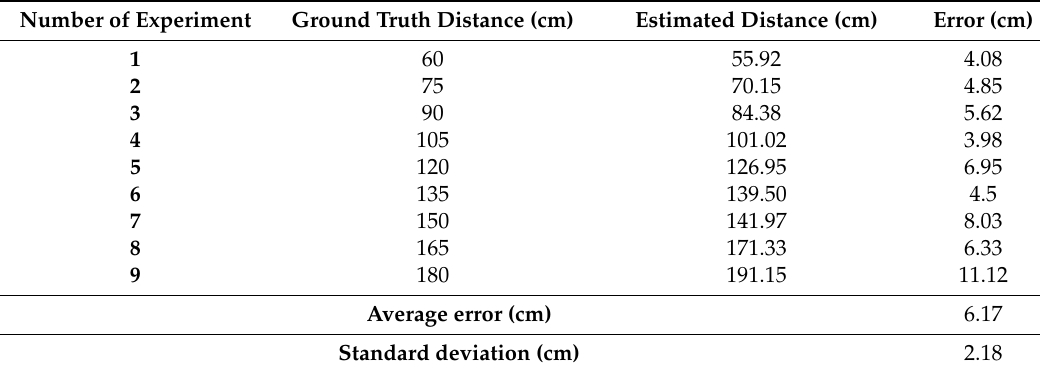
Table 4. Estimation of distance to the